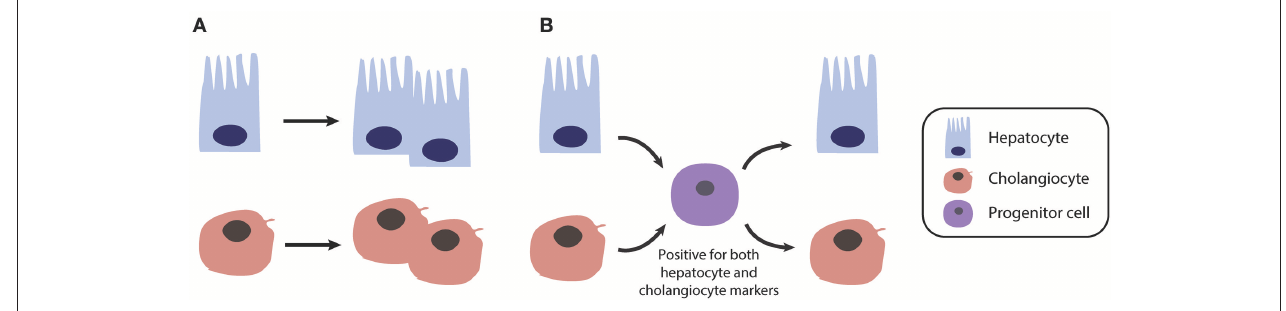
FIGURE 2 | Different mechanisms of liver regeneration in response to acute and chronic liver injury. (A) Regeneration after acute injury, as modeled in 2/3 partial hepatectomy, is primarily driven by self-duplication of all parenchymal cell types (mainly hepatocytes and cholangiocytes). (B) In contrast in chronically injured liver, such as in NAFLD or cholestasis patients, regeneration can occur via transient bipotent progenitor